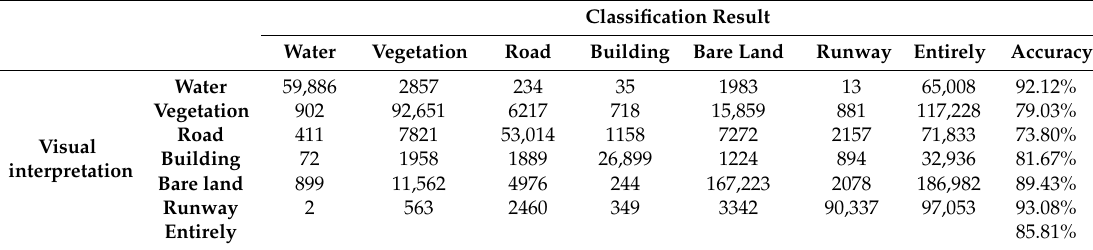
Table 7. Confusion matrix of Multi-source remote sensing data classification results in Pudong International Airport .